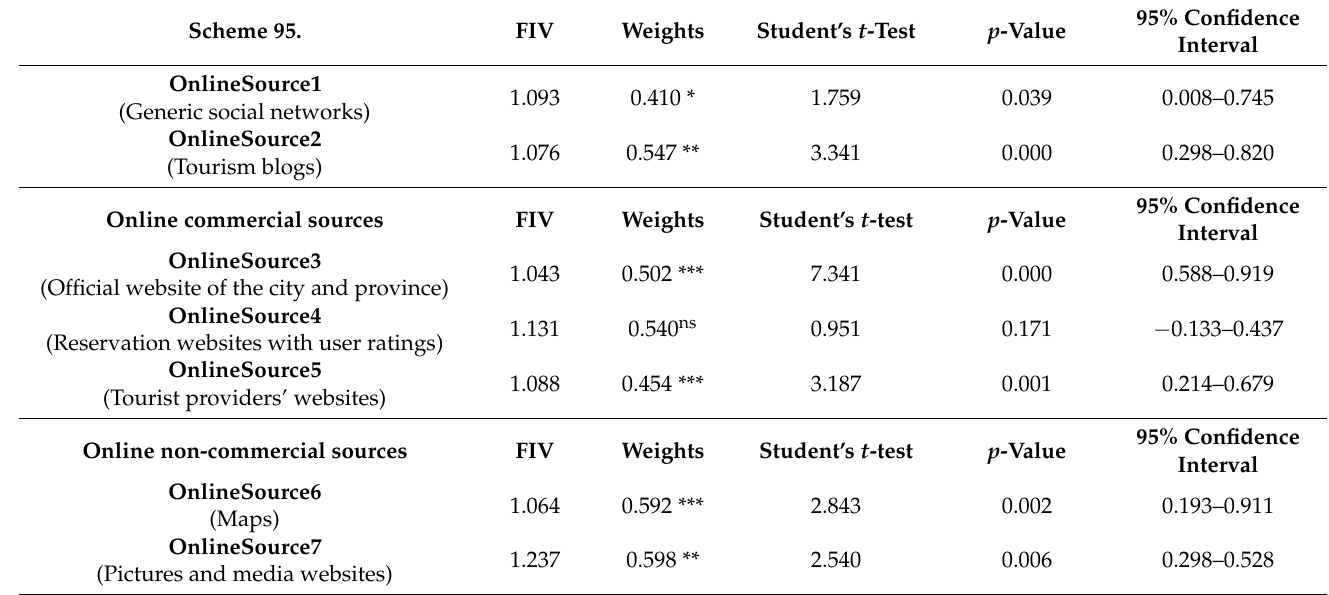
Table 2. Formative constructs and their respective items.